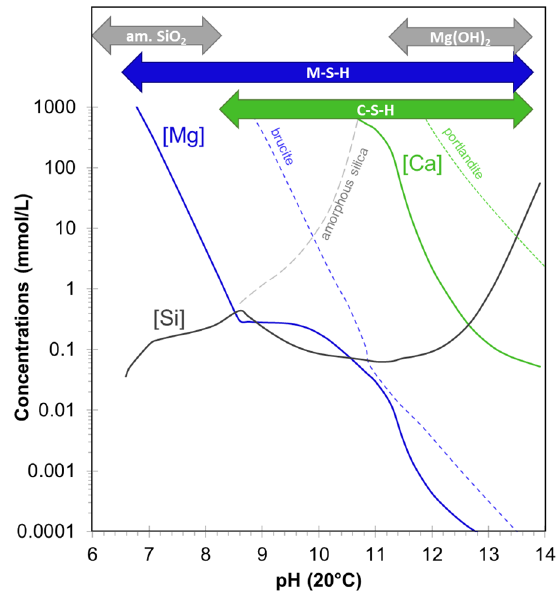
Figure 6. Calculated stability of M ‐ S ‐ H (Mg/Si=1) and C ‐ S ‐ H (Ca/Si=1) and calculated Mg, Ca and Si concentrations between pH 6 to 14. The solubility of brucite, portlandite and amorphous silica are added (as dotted lines for comparison). M ‐ (A ‐ )S ‐ H stability in presence in